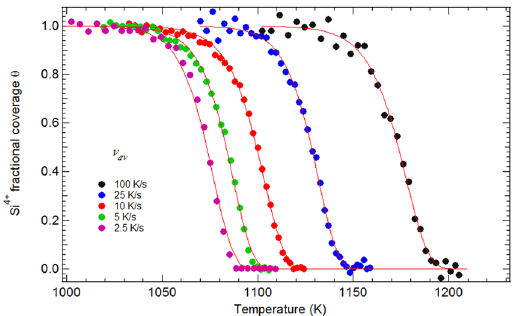
Figure 6. Dependence of the Si 4 + fractional coverage θ (squares) with temperature for five different heating schedules with average velocities v . Red solid lines are fits obtained with the 3-parameter Avrami model. av Corresponding parameters are given in Table 1 together with the χ 2 .